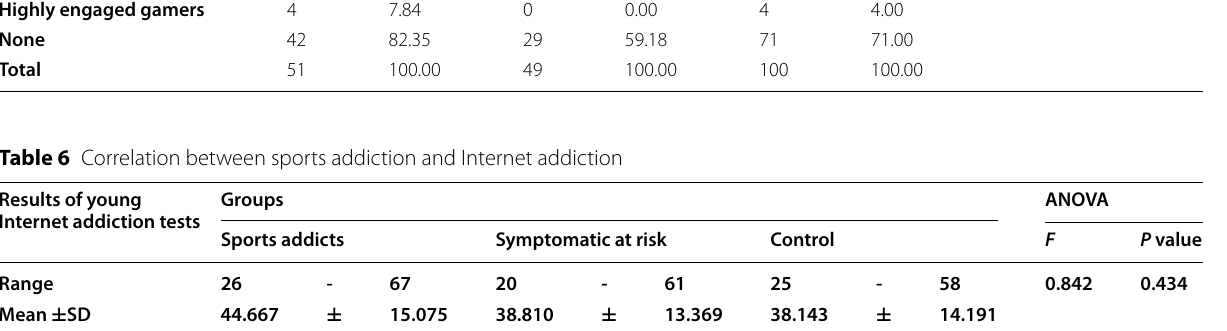
Table 5 Relation of video gaming addiction to risky sports practice Results of video gaming addiction scale